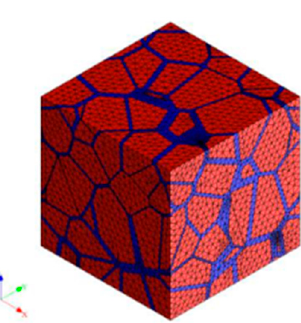
Figure 8. Voronoi unit cell.